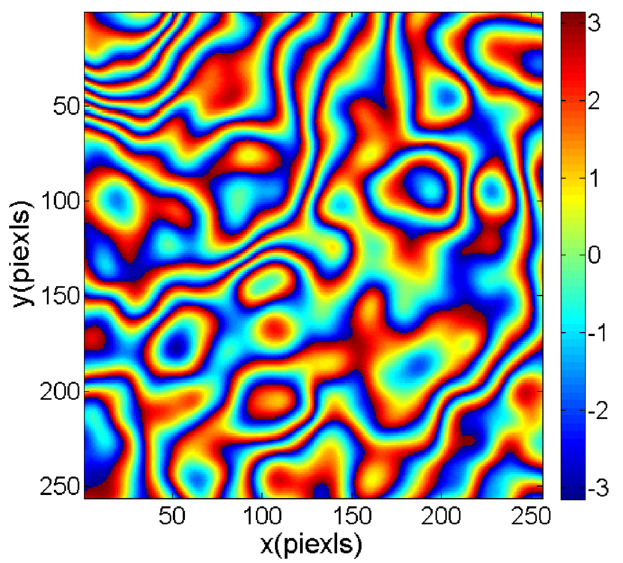
Figure 9. The true phase value of the atmospheric turbulence phase map.